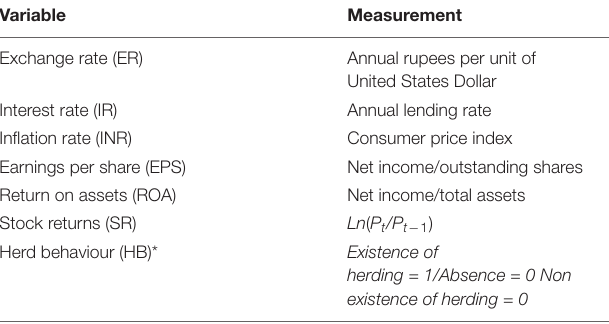
TABLE 1 | Measurement of